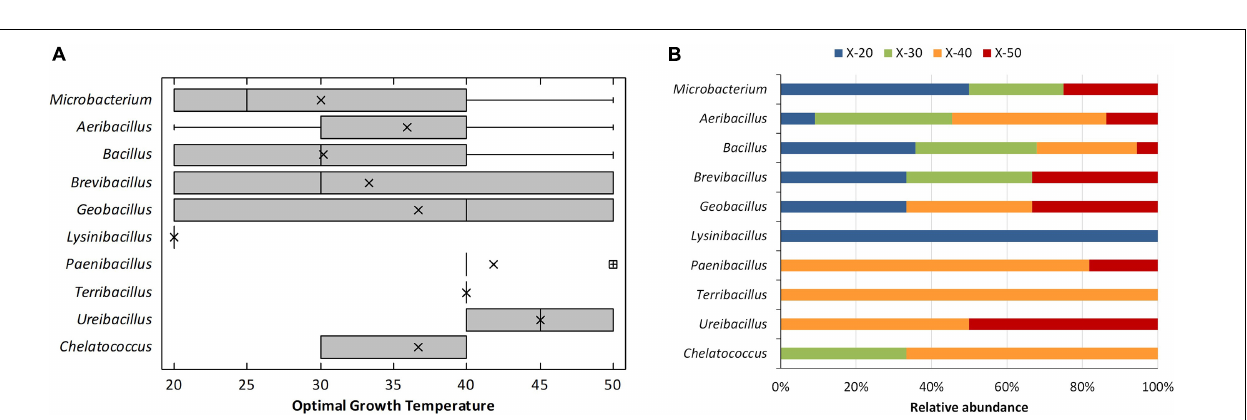
FIGURE 1 | Counts of total and lignocellulolytic thermophilic (A) bacteria (TB), (B) actinobacteria (TA), and (C) fungi (TF). (D) Thermal values and lignocellulose fraction content (%) and degradation (%). Composting stage: RM, raw material; MES, mesophilic; THER, thermophilic; COOL, cooling; FP, final composting product.